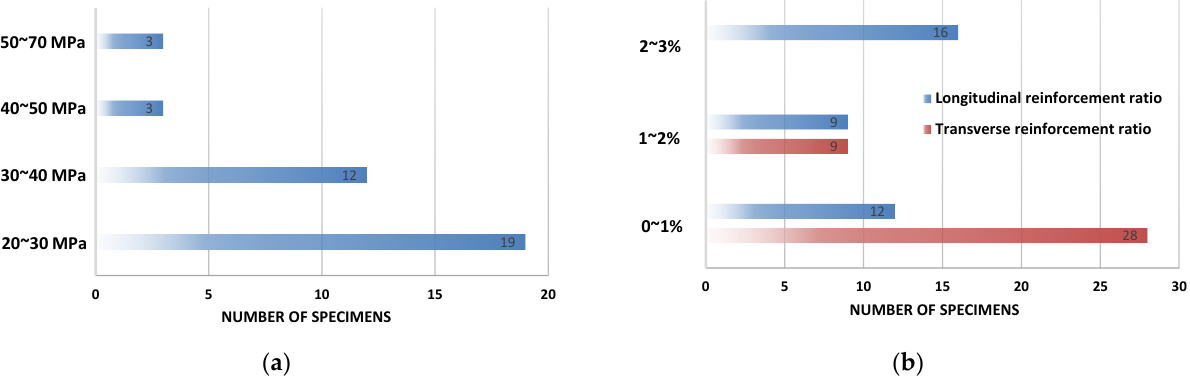
Figure 2. Distribution of key parameters in RCA: ( a ) compressive strength of concrete, MPa ( b ) longitudinal and transverse reinforcement ratios.